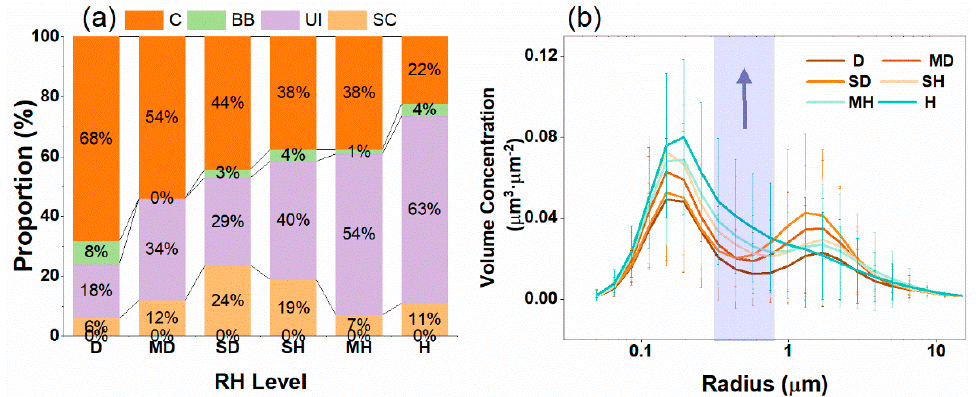
Figure 6. Aerosol type occurrence frequency ( a ) and VSD ( b ), under varying RH levels. The observations are divided into six groups according to RH at 850 hPa: D (dry; RH < 15%), MD (moderately dry; 15% ≤ RH ≤ 25%), SD (slightly dry; 25% ≤ RH < 35%), SH (slightly humid; 35% ≤ RH < 50%), MH (moderately humid; 50% ≤ RH < 60%), and H (humid; RH > 60%).